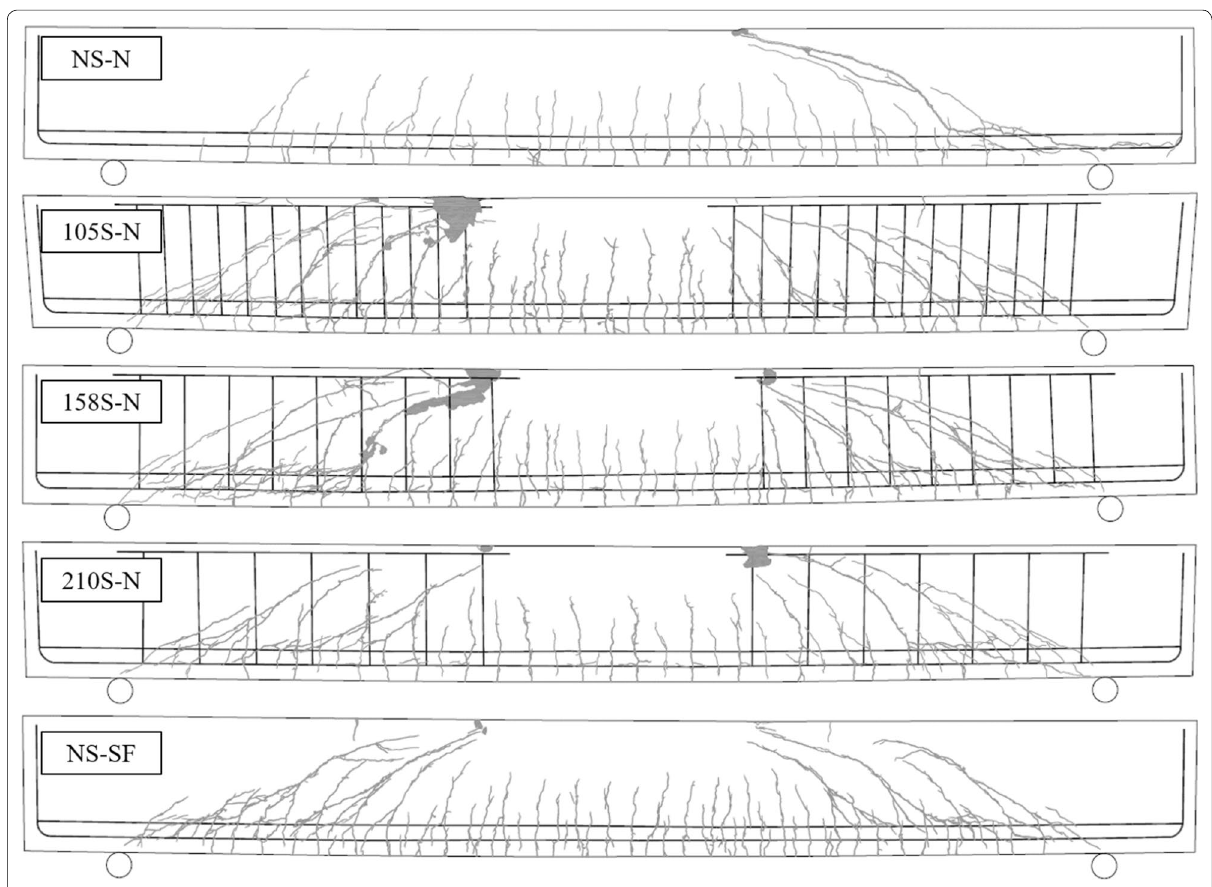
Fig. 9 Cracking patterns and failure